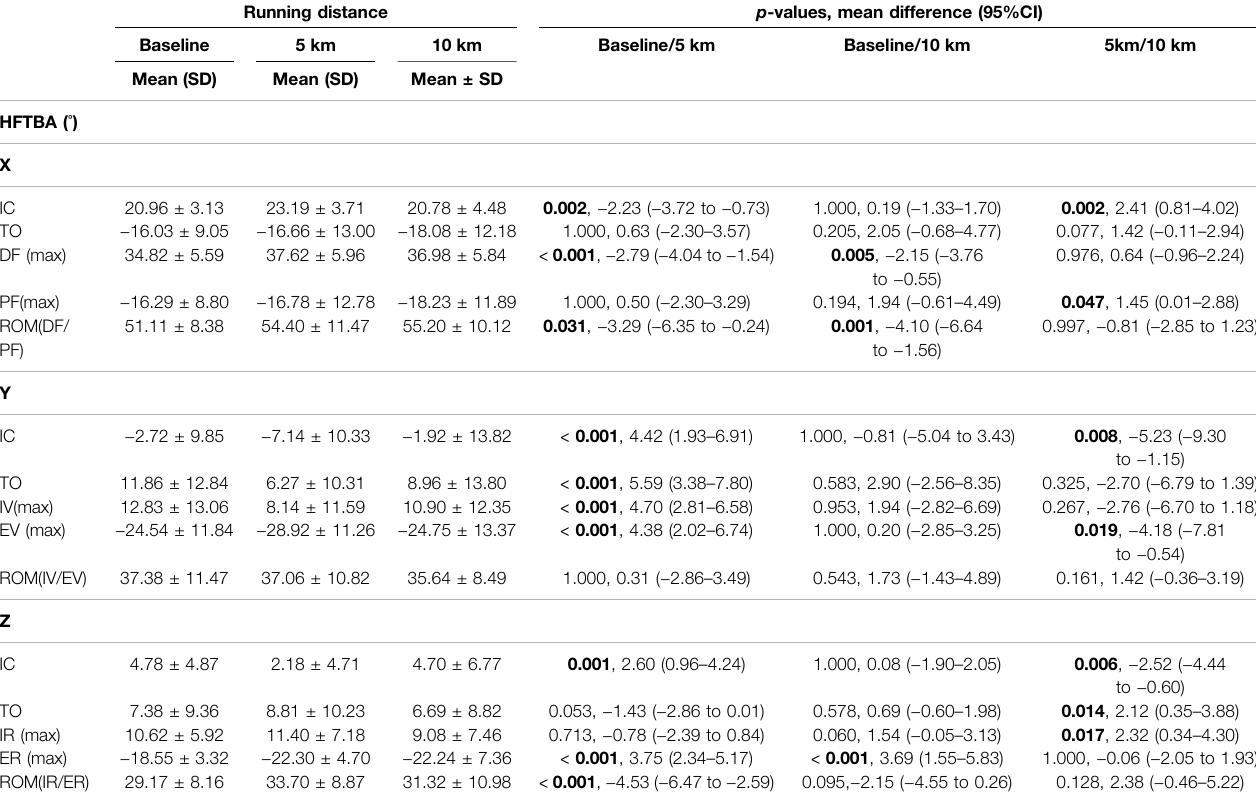
TABLE 3 | Hindfoot with respect to tibia kinematics at baseline and immediately after 5 and 10 km of running.